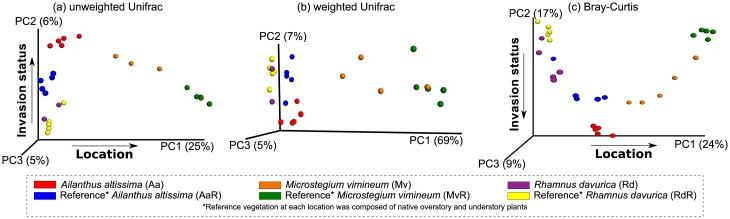
PCoA plot describing (a) un-weighted and (b) weighted Unifrac for bacteria and (c) Bray-Curtis distances for fungi in the invaded and non-invaded sites.Each circle indicates a sample. Multivariate data analysis methods of adonis and ANOSIM were used to identify whether groups were significantly different.